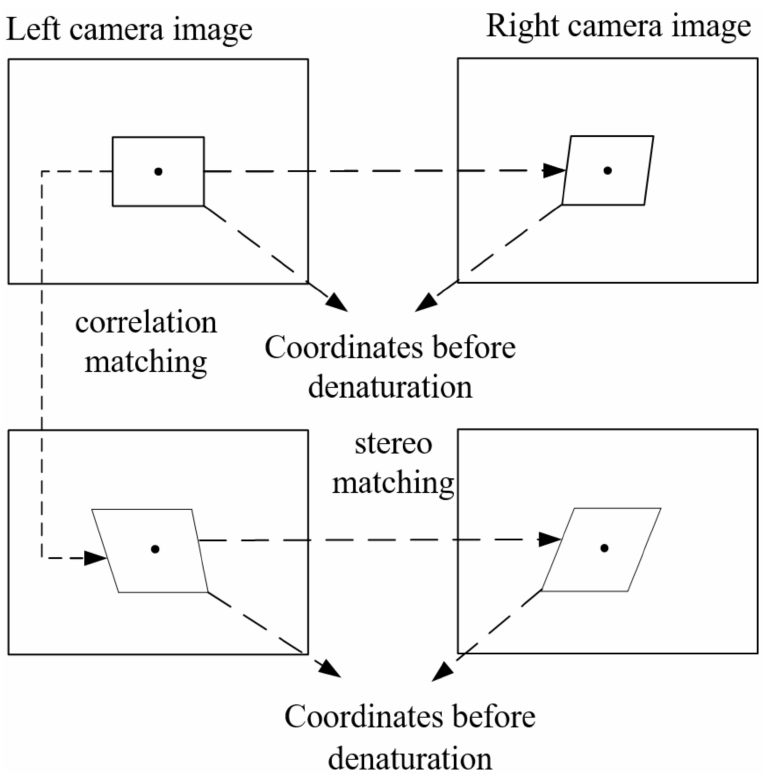
Figure 1. The matching strategy used in this